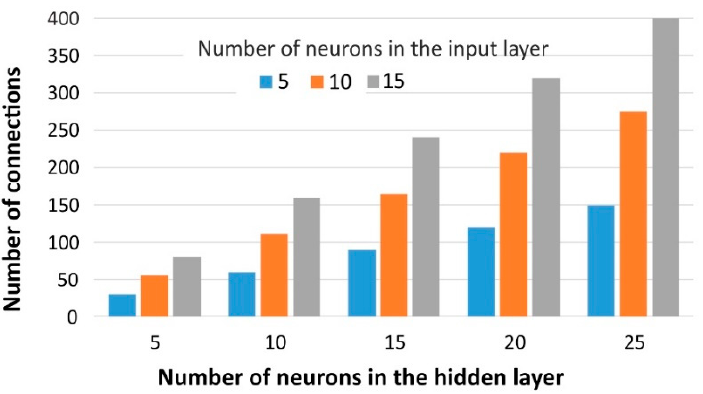
Figure 2. The number of weights in the MLP neural network with one hidden layer and one neuron in the output layer.